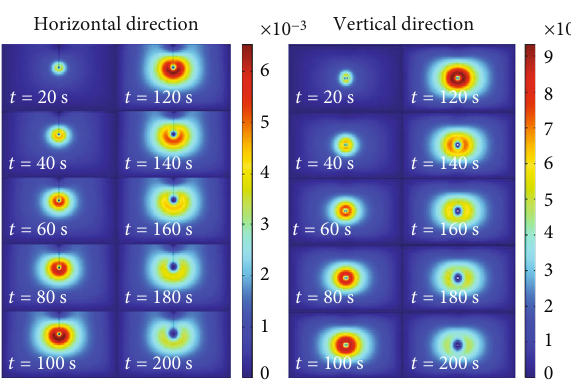
Figure 12: Displacement cloud of coal body at di ff erent